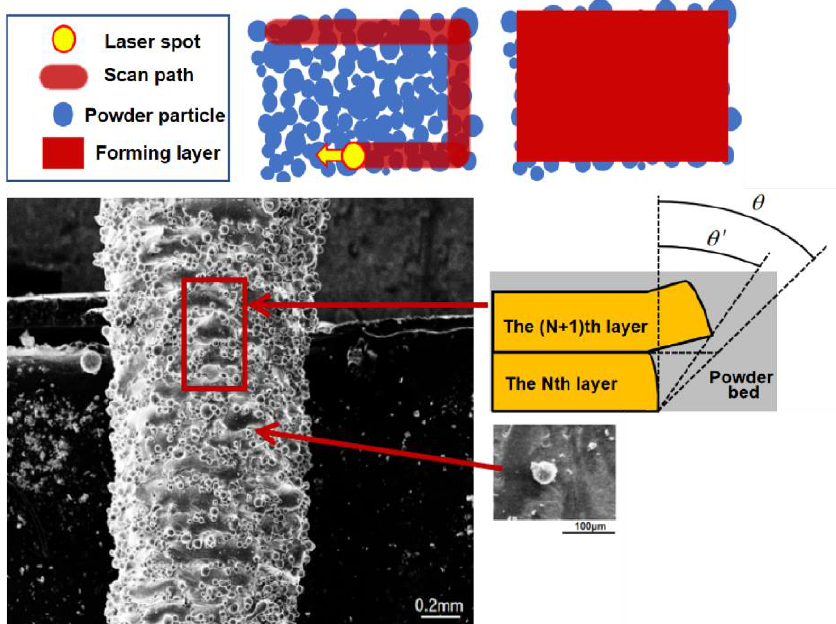
Figure 4. Schematic illustration of the cause of surface bulge geometries in an L-PBFed micro-rod: edge warping of the layered built-up structure and unmelted adhesive powder.